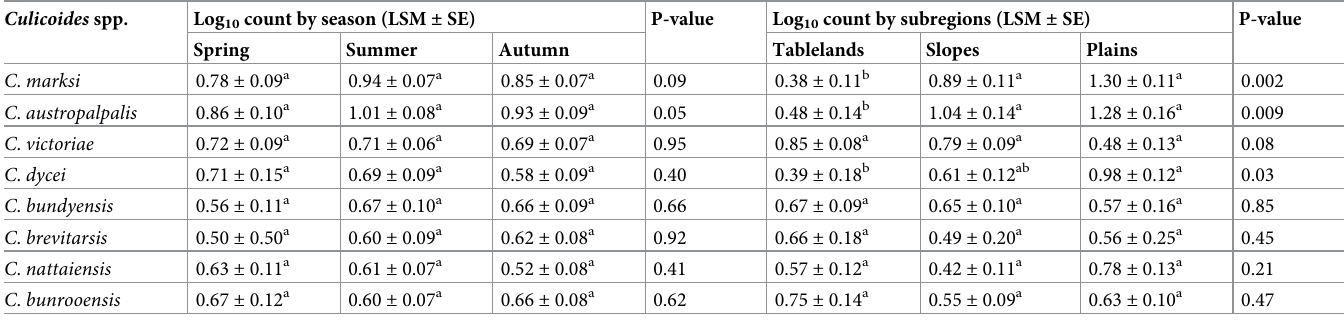
Table 4. Variation on Culicoides species abundance across seasons and subregions trapped in the New England region of NSW, Australia between 1990 and 2018. Culicoides spp.